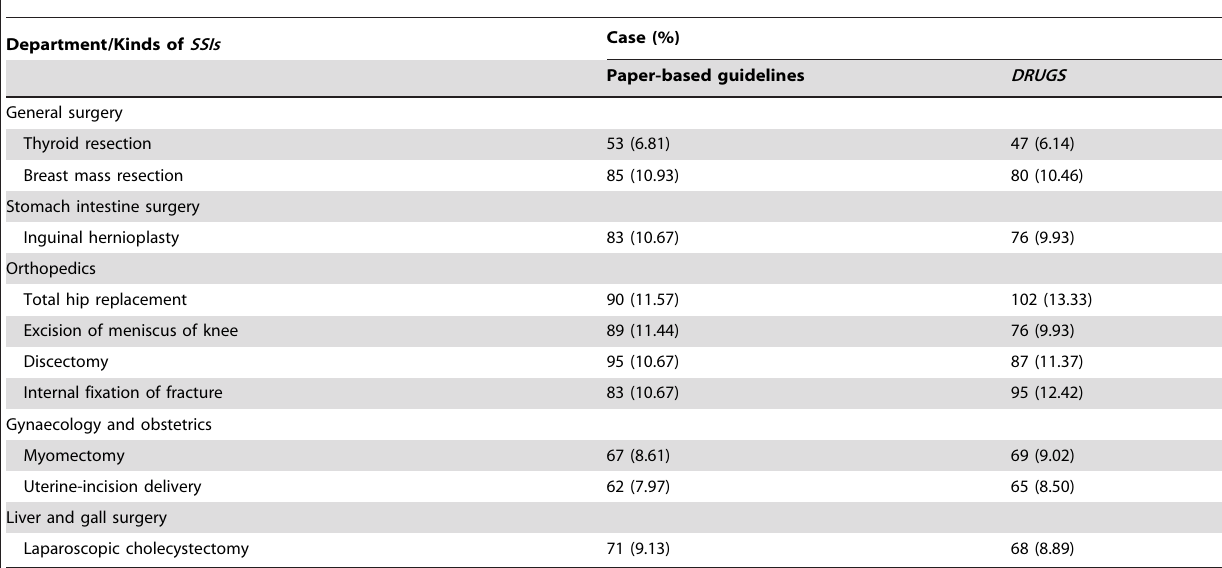
Table 2. The disposition and kinds of SSIs in each period before and after intervention.